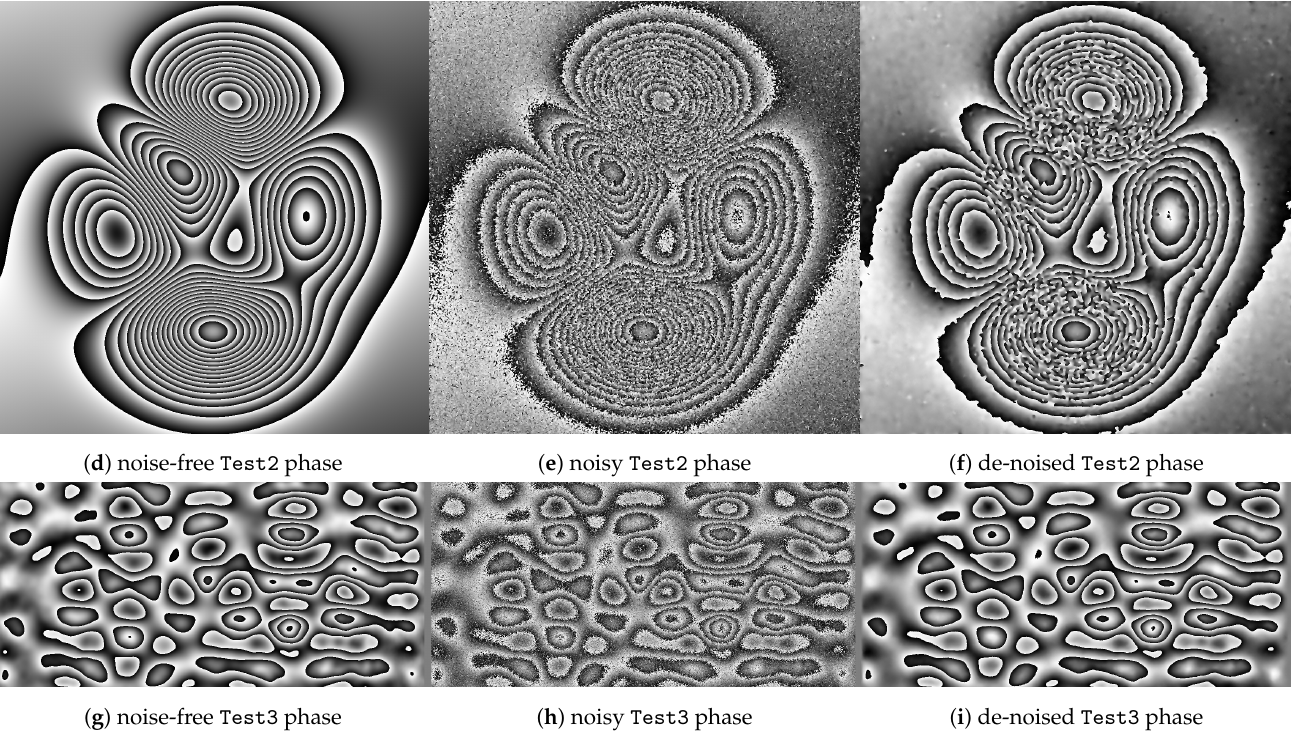
Figure 2. Noise-free ( left ), noisy ( middle ), and de-noised ( right ) phase images from DATAEVAL. De-noising was performed using the DL-Py-1.5-4